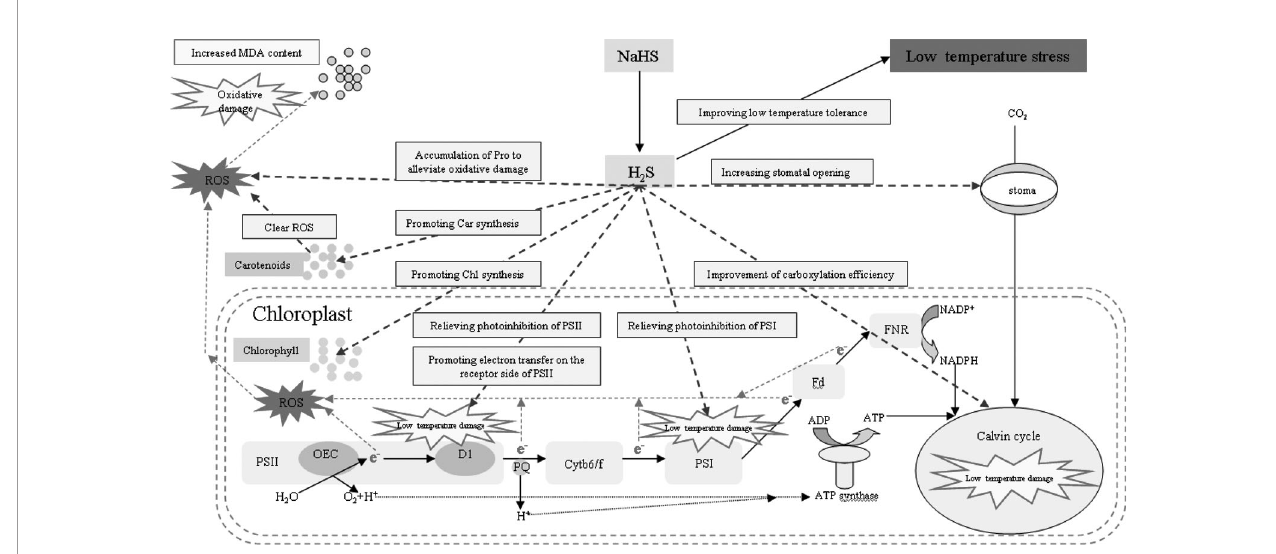
FIGURE 11 | Mechanisms of exogenous H 2 S donor (NaHS) in alleviating photosynthesis inhibition under low temperature